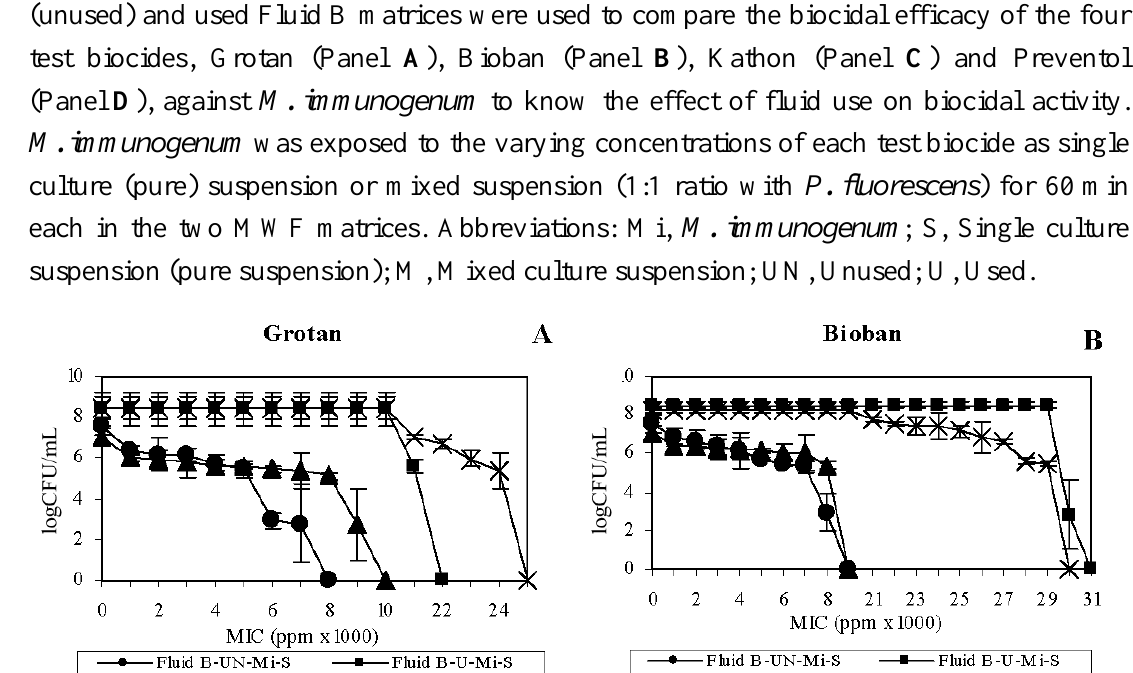
Figure 5. Effect of fluid use on biocidal efficacy toward M. immunogenum .